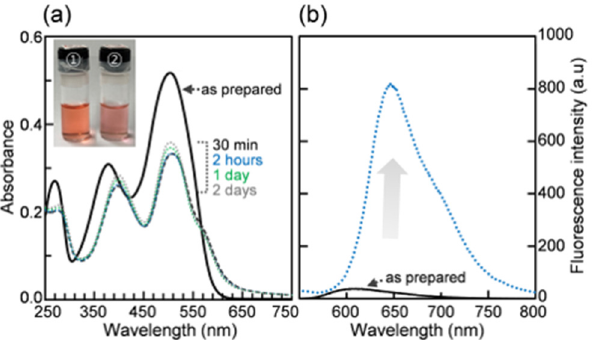
Figure 5. ( a ) Absorption and ( b ) fluorescence ( λ ex = 510 nm) spectra of compound 1 before (10 μ M in THF, black line) and after (10 μ M THF-H 2 O, 1/4, v / v , dotted line) molecular assembly. Inset in ( a ): Photographs of compound 1 in ① THF solution and ② THF-H 2 O mixture.